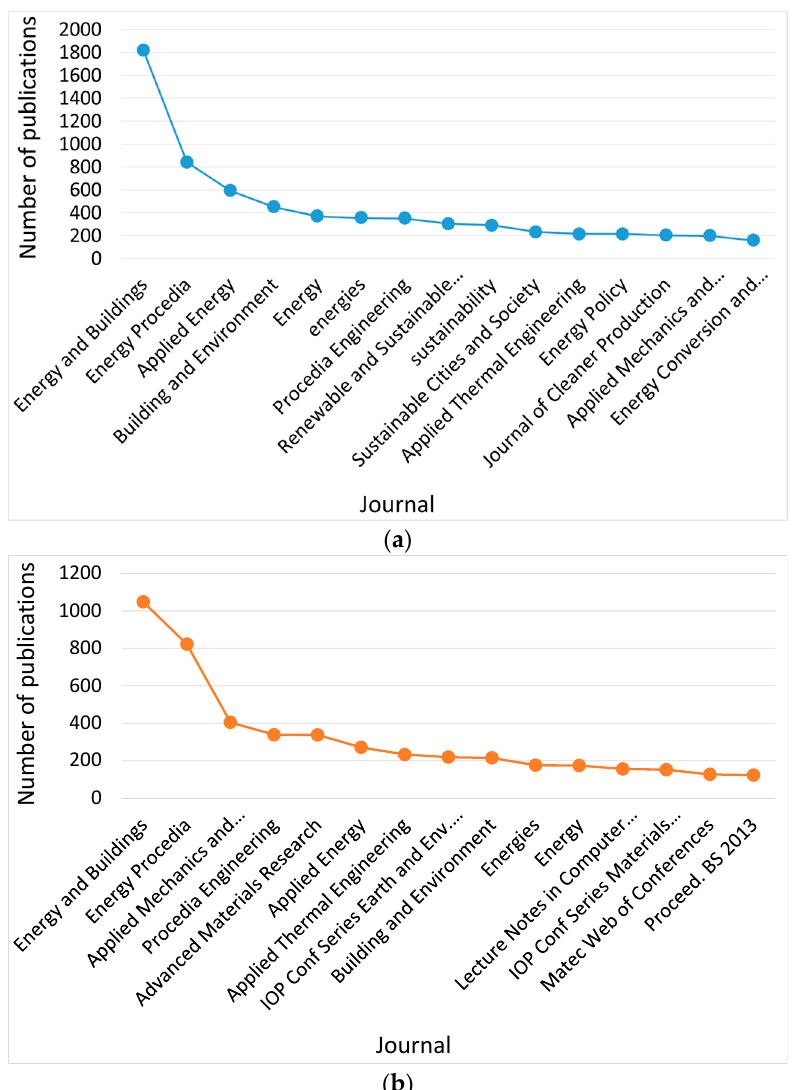
Figure 12. Number of publications in the top 15 journals used in the area of study: ( a ) Web of Science; ( b ) Scopus.